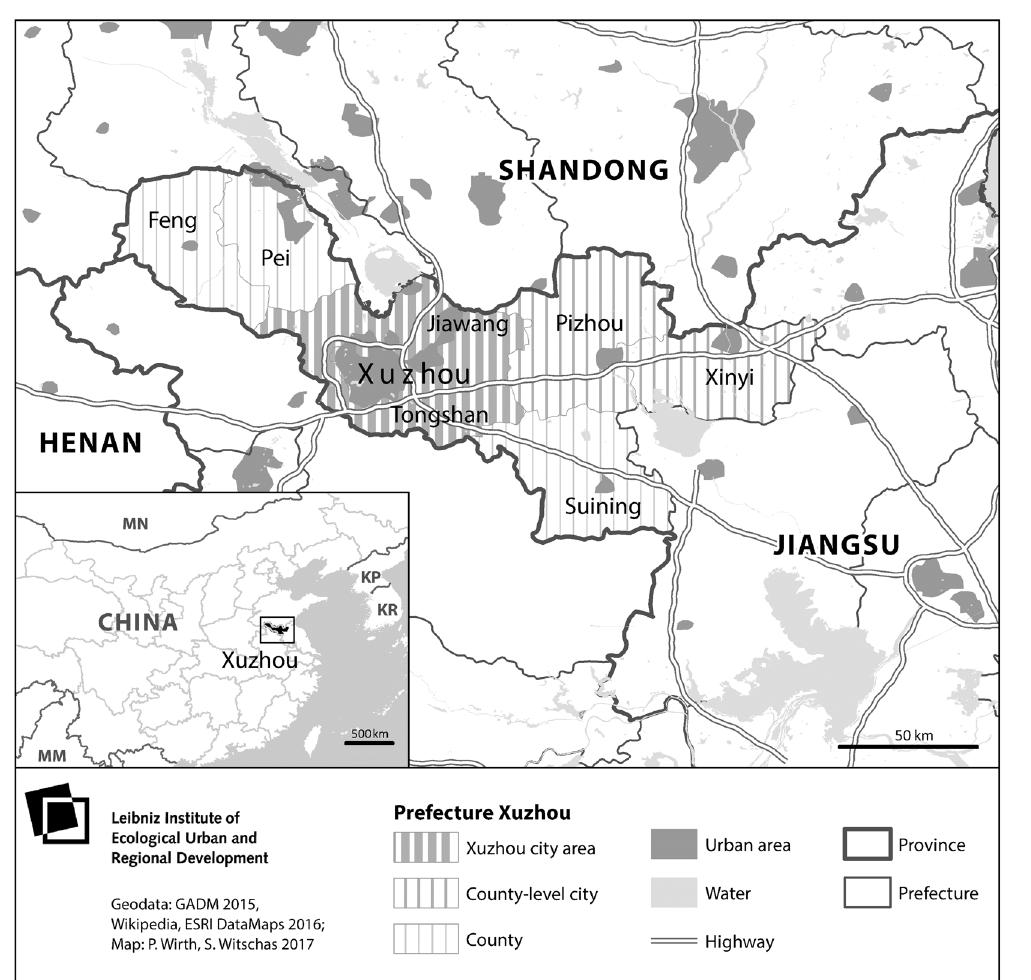
Fig. 3 Study area of